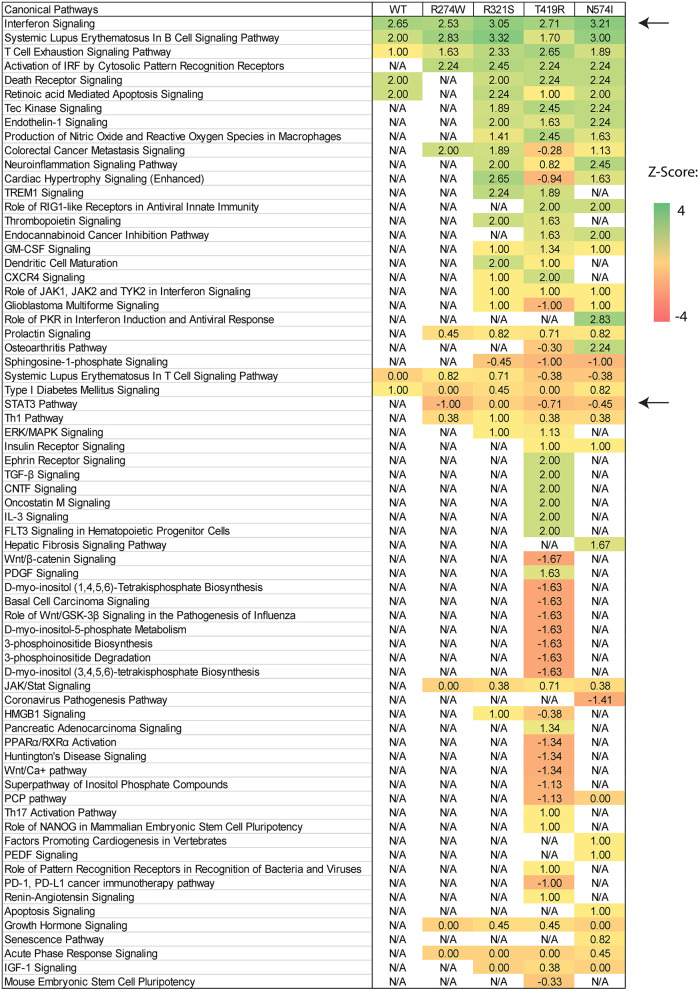
Canonical pathway prediction via IPA on differentially regulated genes for each condition after IFNγ stimulation. Pathway activation is scored using gene expression Z-scores and plotted in an activation Z-score matrix. Z-score represents a measure of how much the specific pathway is predicted to be up- or down-regulated (positive and negative score, respectively). Black arrows point to relevant pathway: Interferon signaling was up-regulated in all samples and STAT3 down-regulated in all GOF conditions, except for the R321S mutant (Z-score= −1, 0, −0.70, −0.47 for R274W, R321S, N574I, and T419R, respectively). For R321S the STAT3 pathway was significantly regulated yet without a clear predominance for up- or down-regulation.